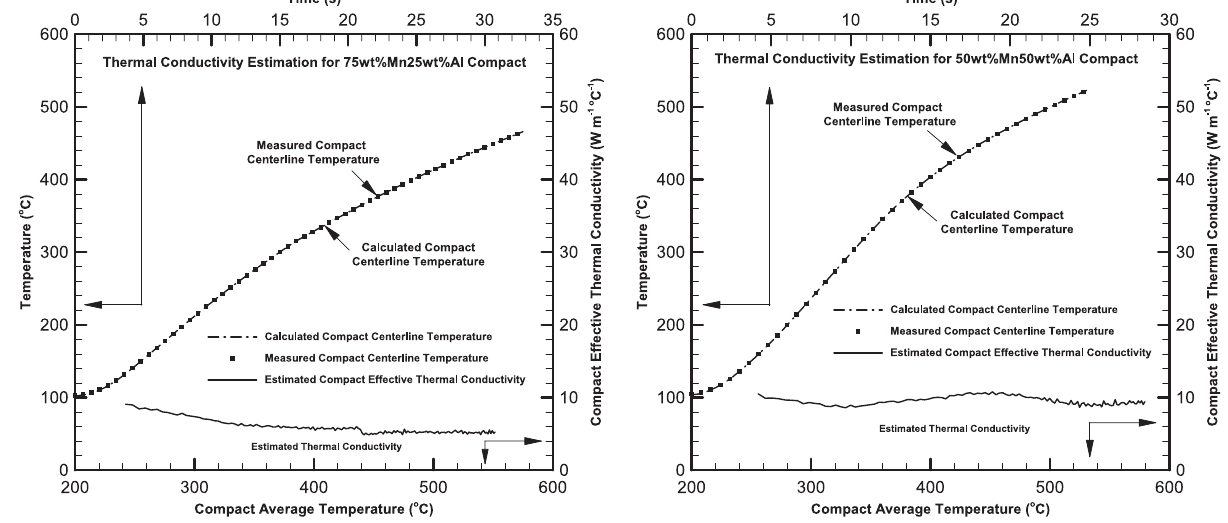
Fig. 12: Estimated Thermal Conductivity of a 75wt%Mn25wt%Al Compact